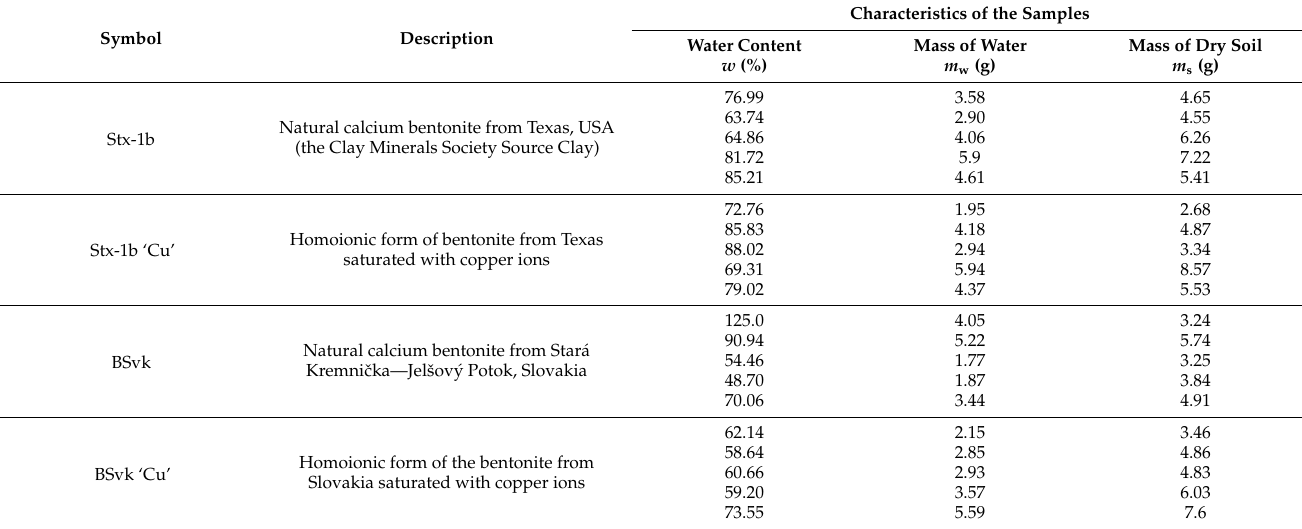
Table 1. Descriptive characteristics and the water contents of the